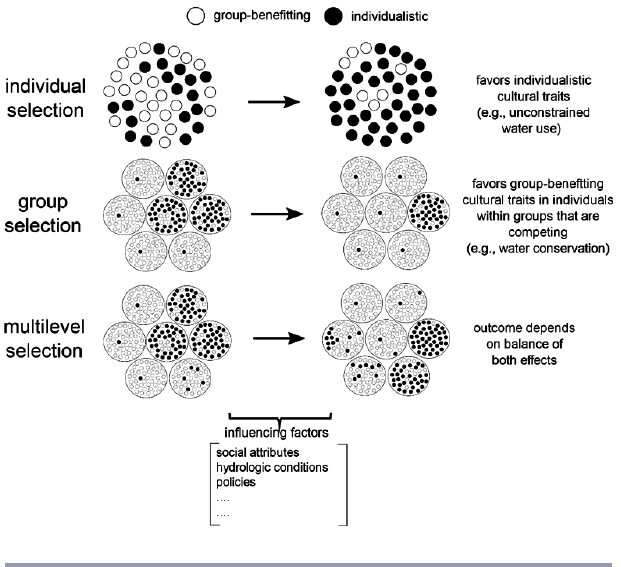
Fig. 3 . An illustration of the cultural multilevel selection (CMLS) framework. Cultural selection can occur at multiple levels (individual, group, or both). When cultural selection is stronger at the group level, a group-benefiting cultural trait proliferates. When selection is stronger at the individual level, an individualistic trait is favored and spreads. Adapted from Waring et al.